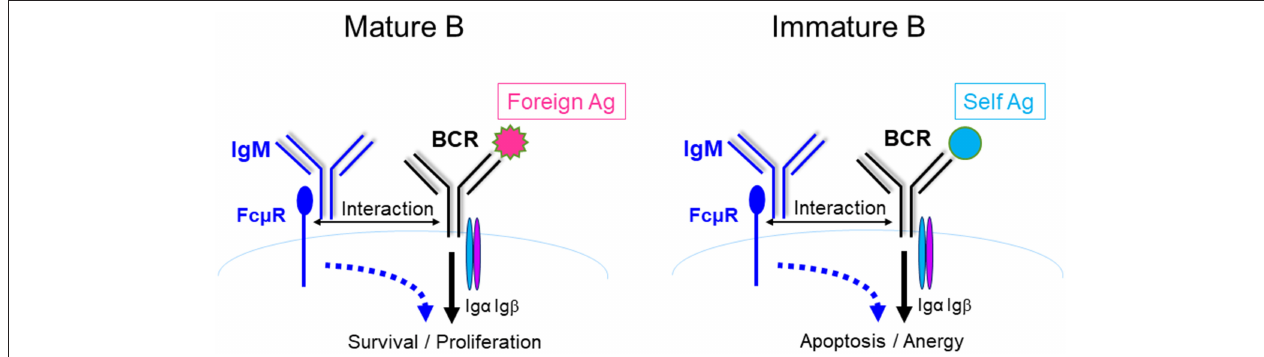
FIGURE 3 | A model for Fc µ R-mediated immunity and tolerance. Fc µ R promotes the survival and activation of mature B cells by interacting with the BCR and potentiating foreign Ag-triggered BCR signaling (left) . By analogy, Fc µ R might also promote self Ag-triggered BCR signaling in immature B cells and contribute to the deletion/anergy of autoreactive immature B cells in the BM (right) . Ag-specific IgM/IgG are illustrated in the scheme shown in Figures 1 , 2 and 4 to suggest that those reactions occur during an immune response. In contrast, IgM shown in this scheme is not Ag-specific to implicate that these reactions can occur in the absence of Ag-specific